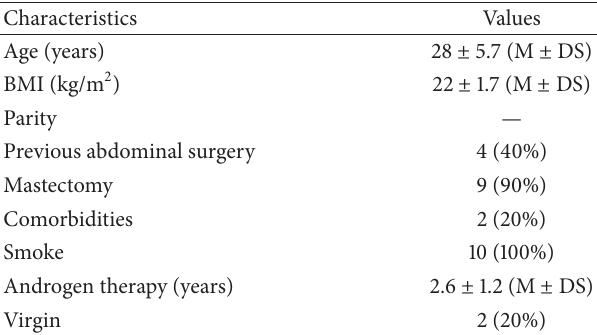
Table 1: Patients’